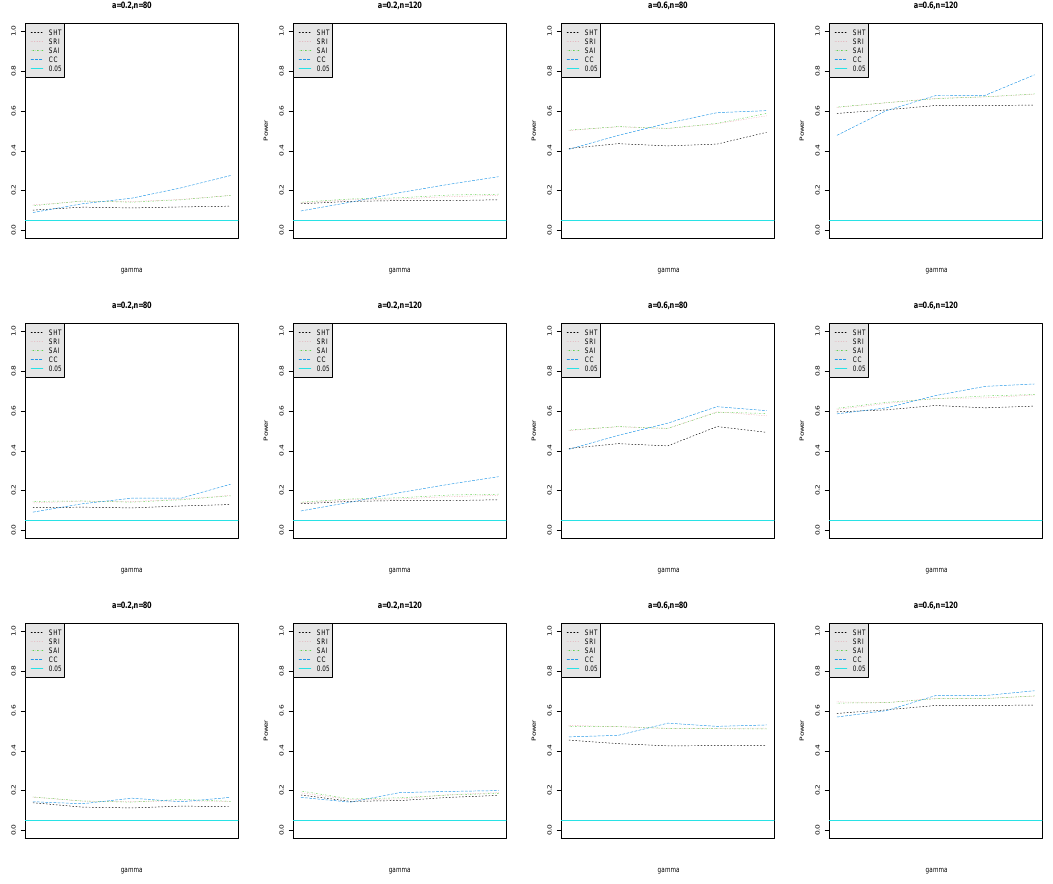
Figure A7. SHT, SRI, SAI and CC represent empirical powers evaluated from IPW, regression imputation, AIPW and CC methods against γ for missingness data mechanism models E2 (the first row), E3 (the middle row) and E4 (the last row) together with ( a , n ) = (0.2,80), (0.2,120), (0.6,80) and (0.6,120), respectively, under the balanced